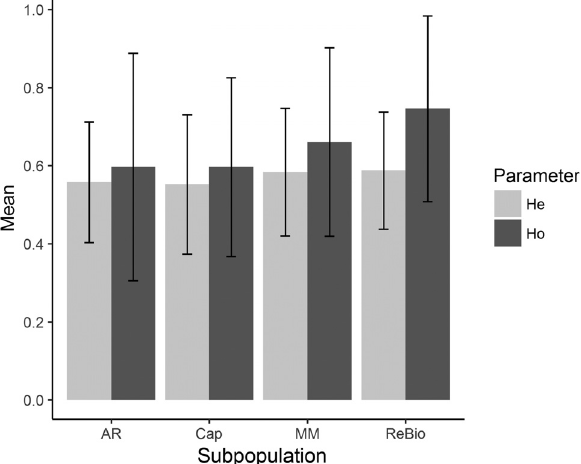
Figure 3 - Observed heterozygosity (Ho) and expected heterozygosity (He) with standard deviation values for E. ovata subpopulations with nSSR markers.